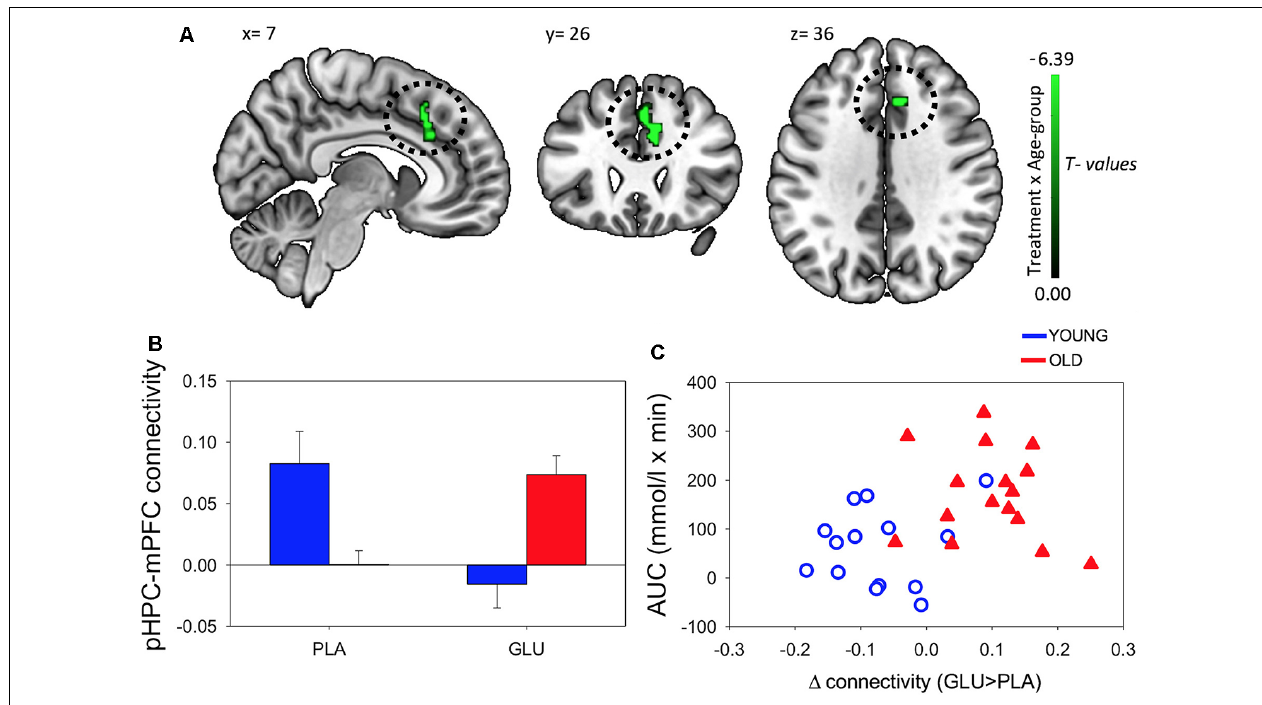
FIGURE 4 | (A) Resting-state functional connectivity (rsFC) brain map for left posterior hippocampus (pHPC) showing: Treatment × Age-group interactions exhibited from left pHPC to cluster in medial frontal cortex (mPFC; encompassing anterior cingulate, paracingulate gyrus and superior frontal gyrus; fisher z-transformed correlation values). (B) Extracted connectivity strength from pHPC to mPFC for each group per session (error bars reflect SEM). (C) Scatterplot of correlation between change in rsFC of pHPC and mPFC and glucose regulation as measured by iAUC ( r = 0.39, P = 0.04).